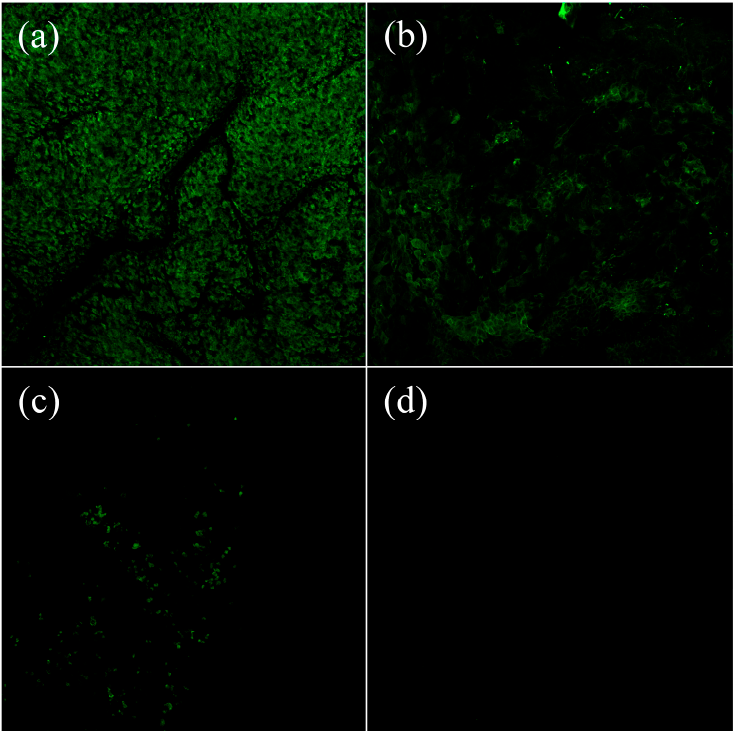
Figure 3. Microscopical visualisation of the lectin binding patterns of ( a ) F-WGA, ( b ) F-UEA I, ( c ) F-PNA, and ( d ) F-BSA after incubation at 4 °C.